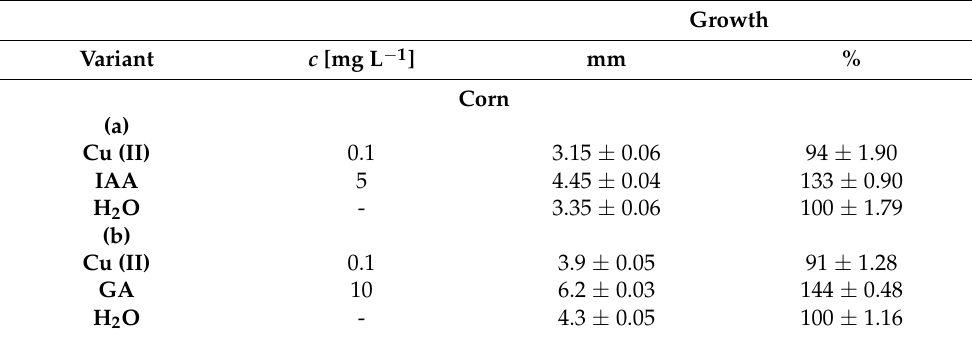
Table 3. Influence of Cu(II) complex solution (a) on the growth of whole corn coleoptiles in 24 h and (b) on the growth of the 1st leaf of the sections of corn seedlings in 24 h a ( n = 30). Water was used as a control, indole-3-acetic acid (IAA) and gibberellic acid (GA) as